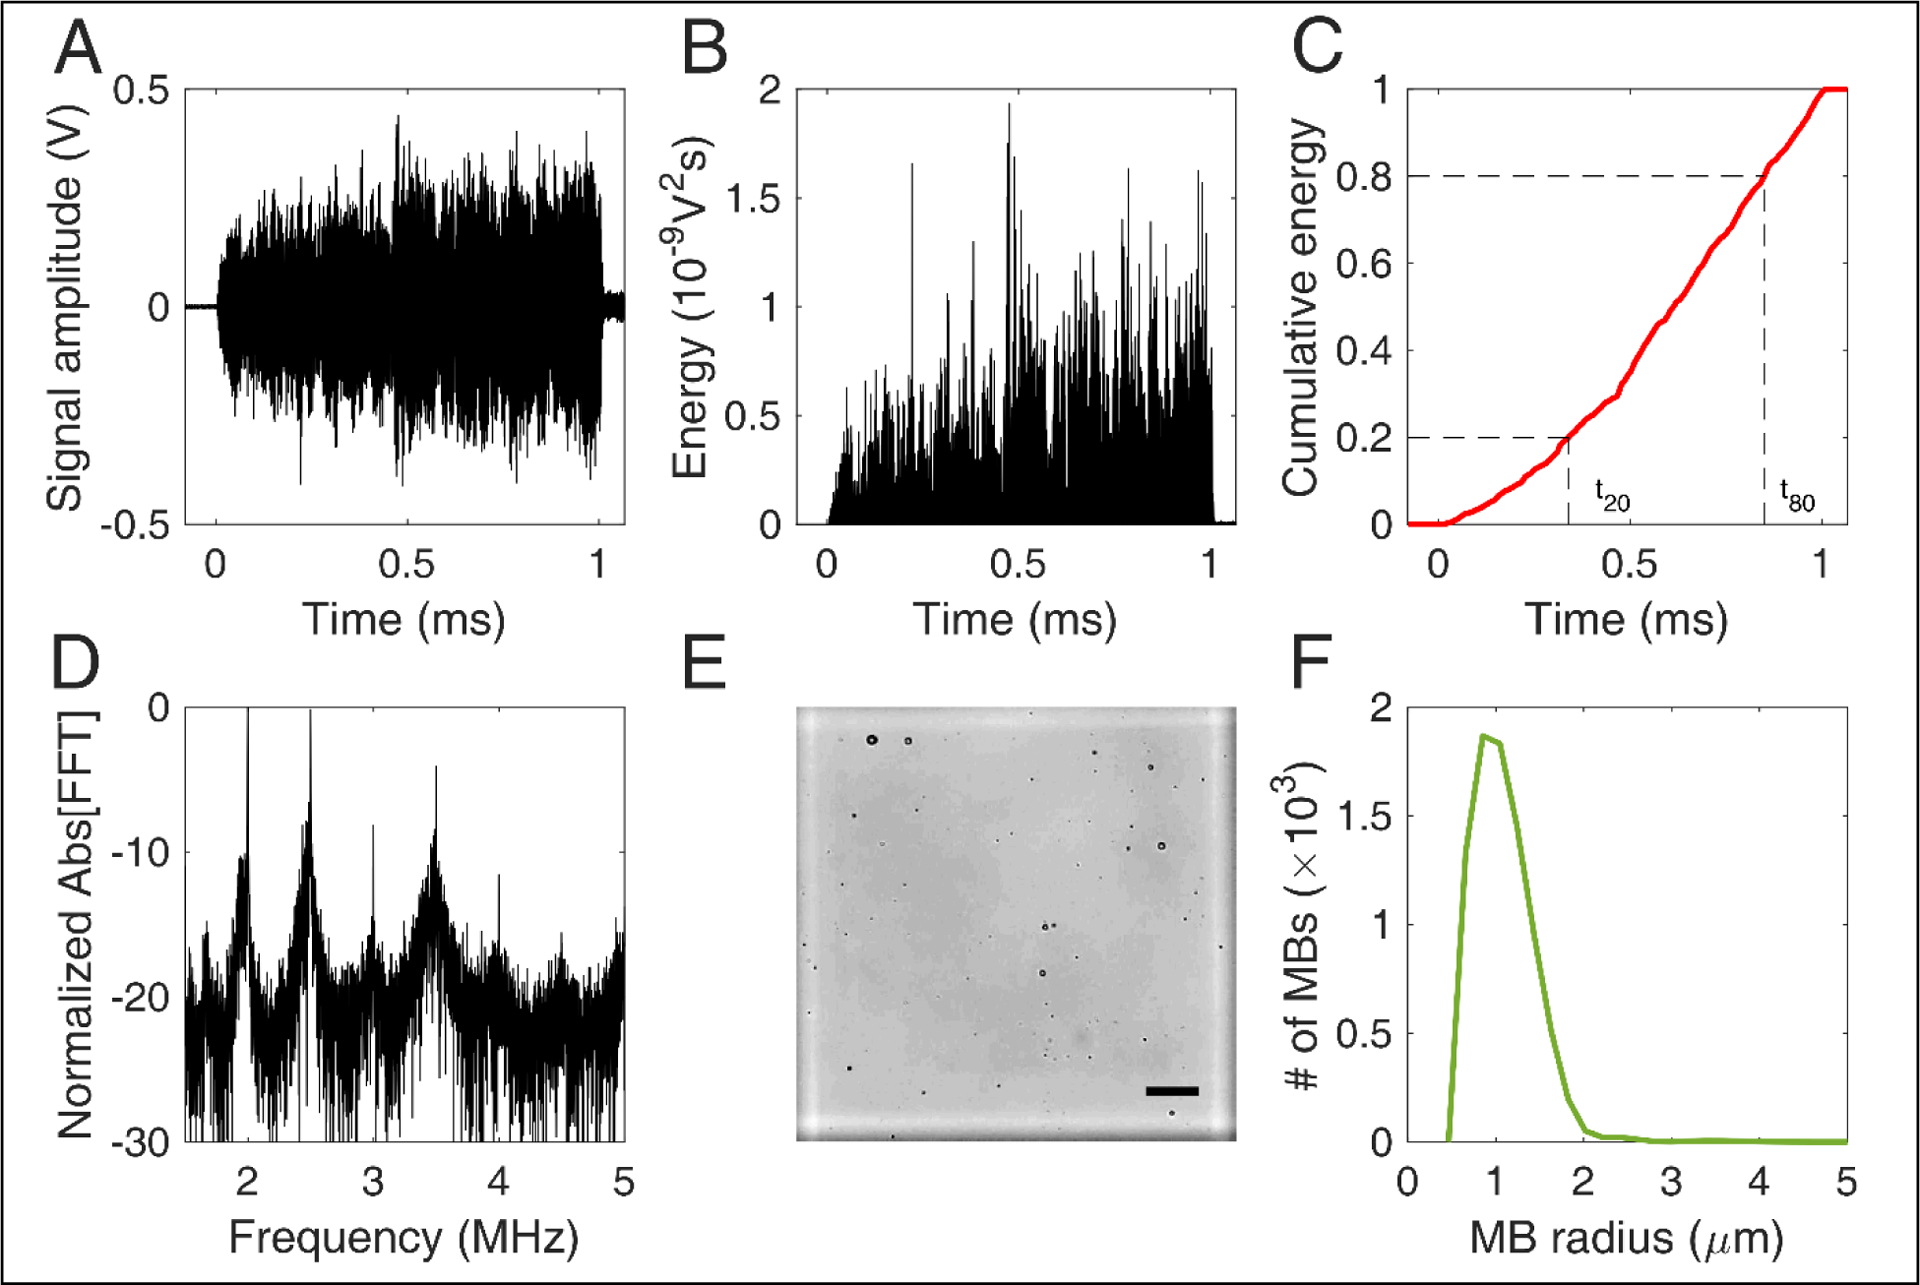
Signal and image processing.(A) Time-domain signal capturing cavitation emissions during the 1-ms-long therapeutic pulse. B) Energy evolution during a single pulse. (C) Normalized cumulative energy during a single pulse. Time constants t20 and t80 were defined as the time required for 20% and 80% of the total acoustic energy to be emitted, respectively. D) Normalized amplitude of fast Fourier Transform (FFT) performed over the cavitation emissions produced by a single pulse. (E) Example of an optical microscopy image acquired for microbubble counting and sizing. The marked square of the hemocytometer is in white. Scale bar: 50 μm. (F) Microbubble size distribution estimated through optical microscopy.